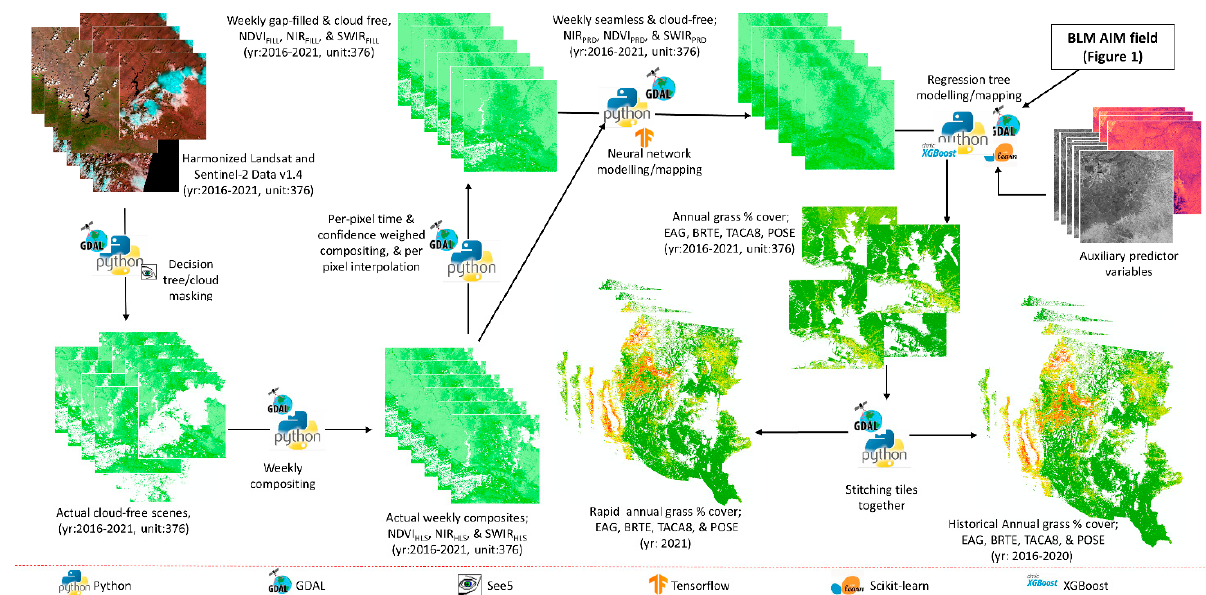
Figure 2. Schematic diagram showing pre-processing steps, modelling tasks and outcomes, and tools used for each step. NDVI is Normalized Different Vegetation Index, NIR is near infrared, SWIR is shortwave infrared, and subscripted HLS, FILL, and PRD stand for cloud/shadow cleaned, gap-filled, and predicted, respectively. EAG represents a combination of 16 exotic annual grasses, BRTE is cheatgrass, TACA8 is medusahead, and POSE is Sandberg bluegrass. BLM AIM is the Bureau of Land Management Assessment, Inventory, and Monitoring program, and GDAL stands for Geospatial Data Abstraction